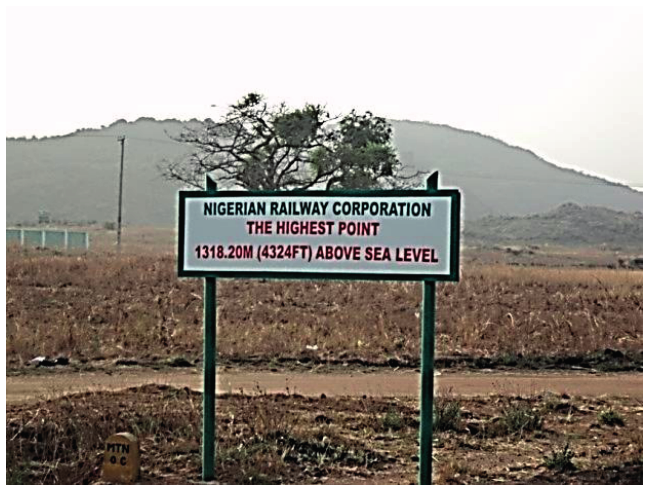
Figure 1. Study area.